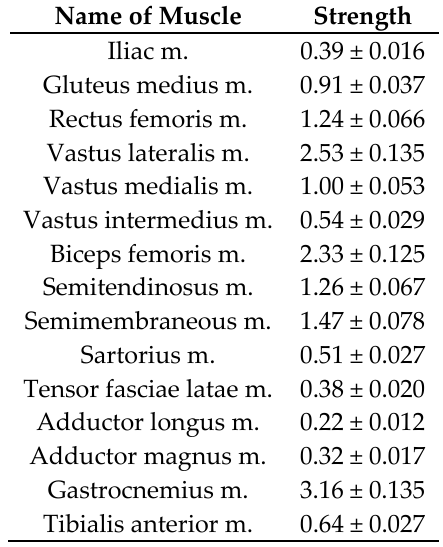
Table 1. Strength of each muscle (mean ± SD (unit